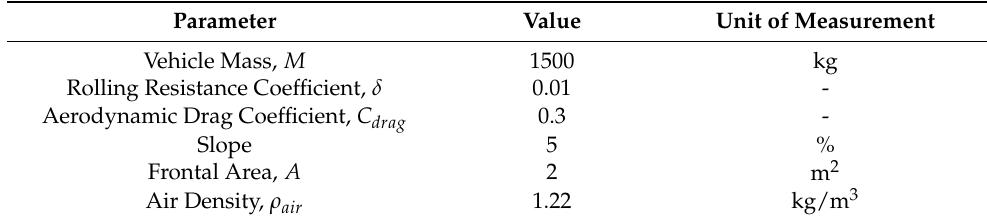
Table 5. Vehicle Configuration Parameters.